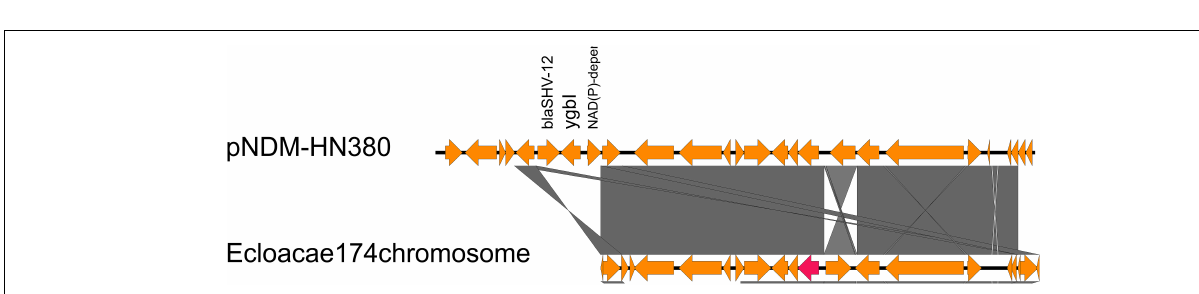
FIGURE 2 | Summary of sub-classifications of resistance gene environment.